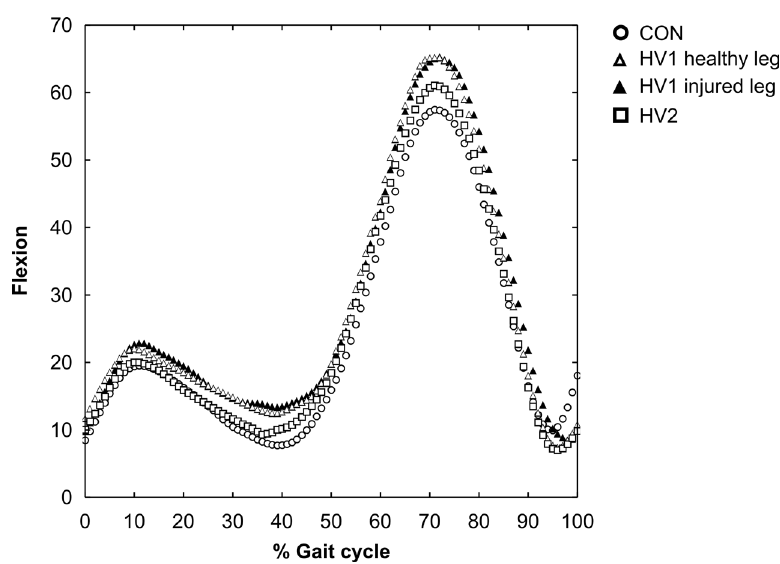
Fig.3 Knee flexion/extension angular position (in deg) during the gait